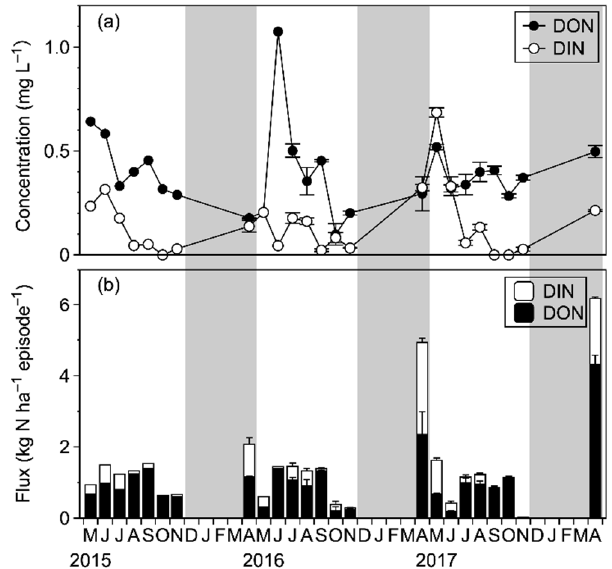
Figure 3. Average monthly concentration (mg L − 1 ) ( a ) and average flux (kg N ha − 1 episode − 1 ) ( b ) of dissolved nitrogen in bulk precipitation from May 2015 to April 2018. Shaded areas show snow seasons. Sampling in the snow season was once per season. Error bars show standard error ( n = 3). DON = Dissolved organic nitrogen; DIN = Dissolved inorganic nitrogen.